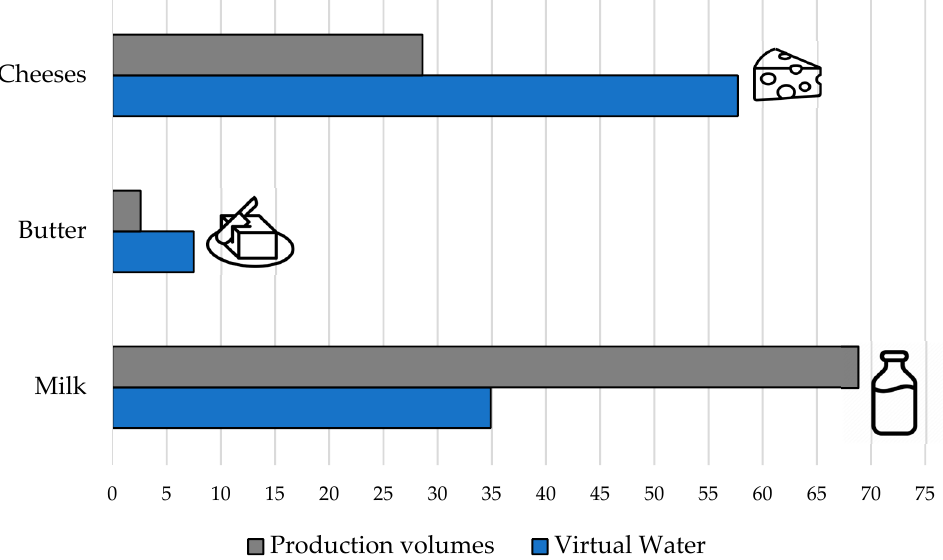
Figure 4. Percentage of the main product categories on the total quantity of production and on the total consumption of water in the dairy sector.